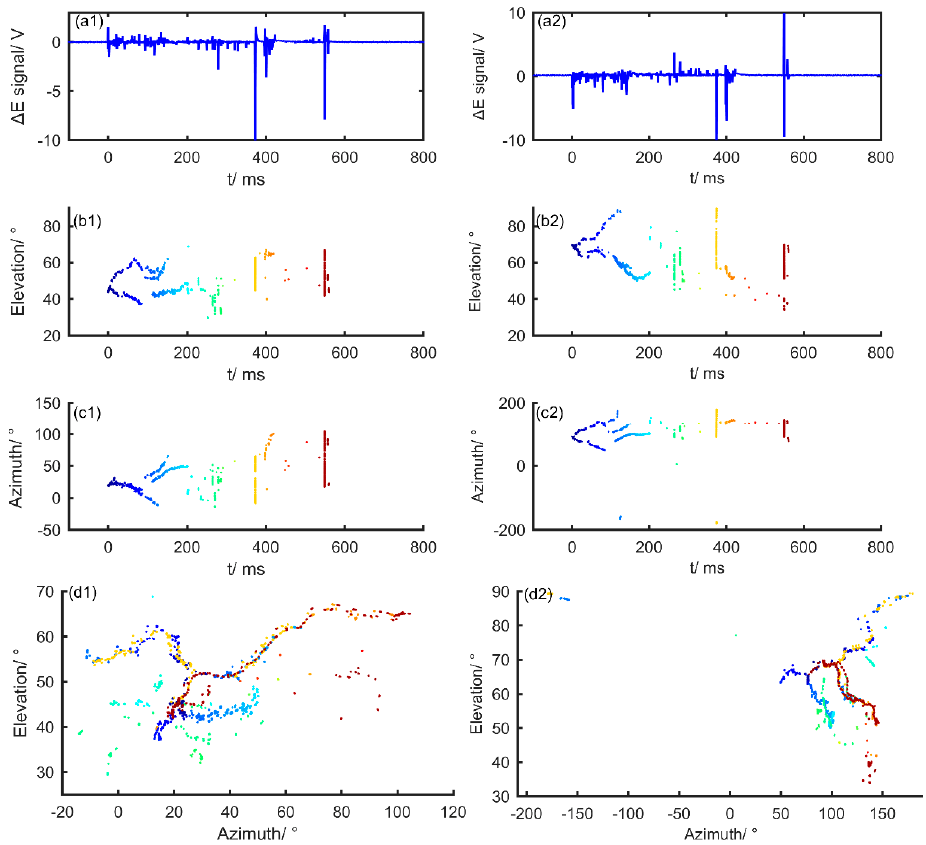
Figure 4. The two-station 2-D locating results of an IC flash. ( a1 ) the fast electric field change waveform observed by site A; ( b1 ) elevation angle change with time observed by site A; ( c1 ) azimuth angle change with time observed by site A; ( d1 ) azimuth versus elevation 2-D images observed by site A. ( a2 ) the fast electric field change waveform observed by site B; ( b2 ) elevation angle change with time observed by site B; ( c2 ) azimuth angle change with time observed by site B; ( d2 ) azimuth versus elevation 2-D images observed by site B.